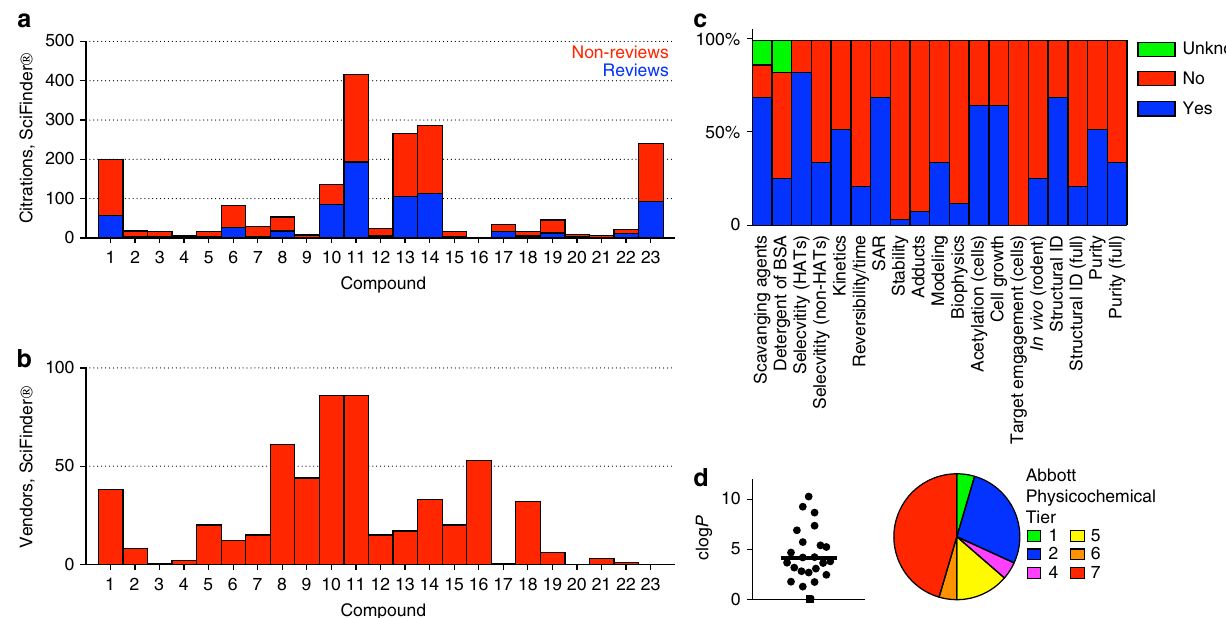
Fig. 5 Literature, vendor, and cheminformatics analyses of reported HAT inhibitors show concerning trends. a Many HAT inhibitors are highly prevalent in the scienti fi c literature. Shown are the number of reviews (blue subset), non-reviews (red subset), and total unique citations (red plus blue subsets) cataloged in the SciFinder® database for the original reports of compounds 1 – 23 as HAT inhibitors. Data accessed 03 June 2017. b Most HAT inhibitors are widely commercially available. Shown are the number of vendors listing compounds 1 – 23 for purchase according to the SciFinder® database, either in-stock or synthesis-on-demand. Data accessed 03 June 2017. c Analysis of original publications for compounds 1 – 23 shows common experiments for compound selectivity, mechanism of action, assay interference, target engagement, and purity/identity are not routinely performed. d Many of the reported HAT inhibitors tested have poor calculated physicochemical properties (log P ,